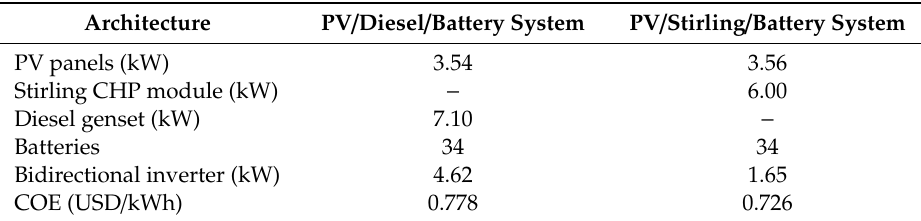
Table 8. Results of HOMER